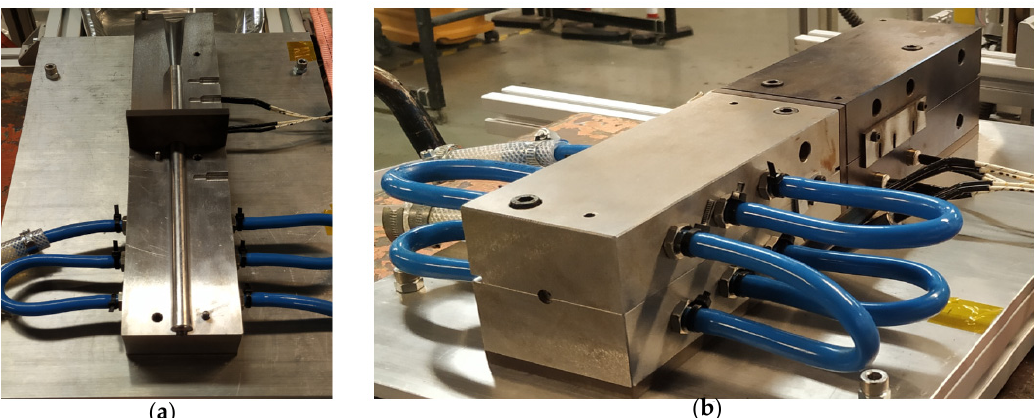
Figure 6. Manufactured die for the production of reinforced thermoplastic filaments. ( a ) middle section view of the die. The internal tubular structure can be replaced, allowing the productio nof different filament sizes and geometries; ( b ) Full view of the